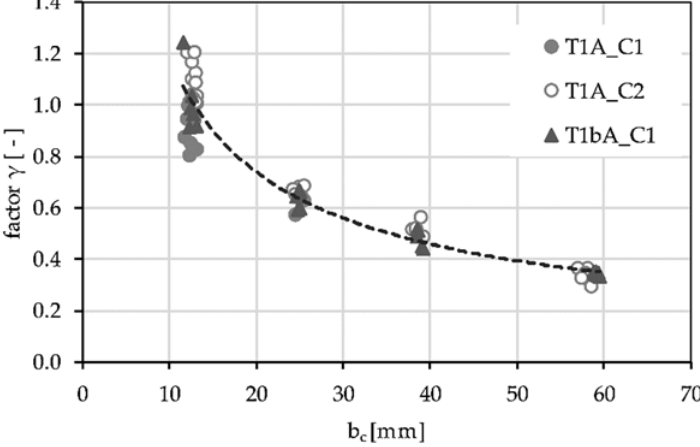
Figure 12. Factor γ for considering the stress distribution in the concrete in relation to the concrete width per fiber strand (b c ). width per fiber strand (b c